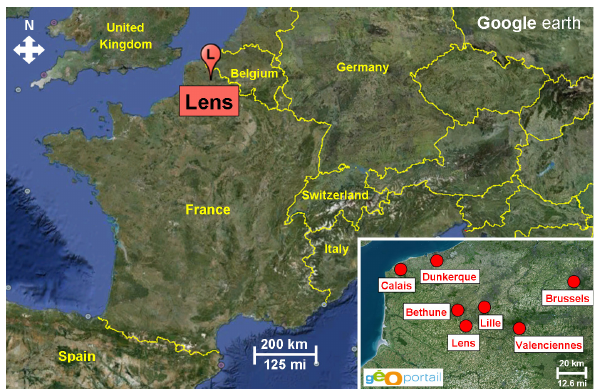
Fig. 1. Localization of the sampling site and surrounding